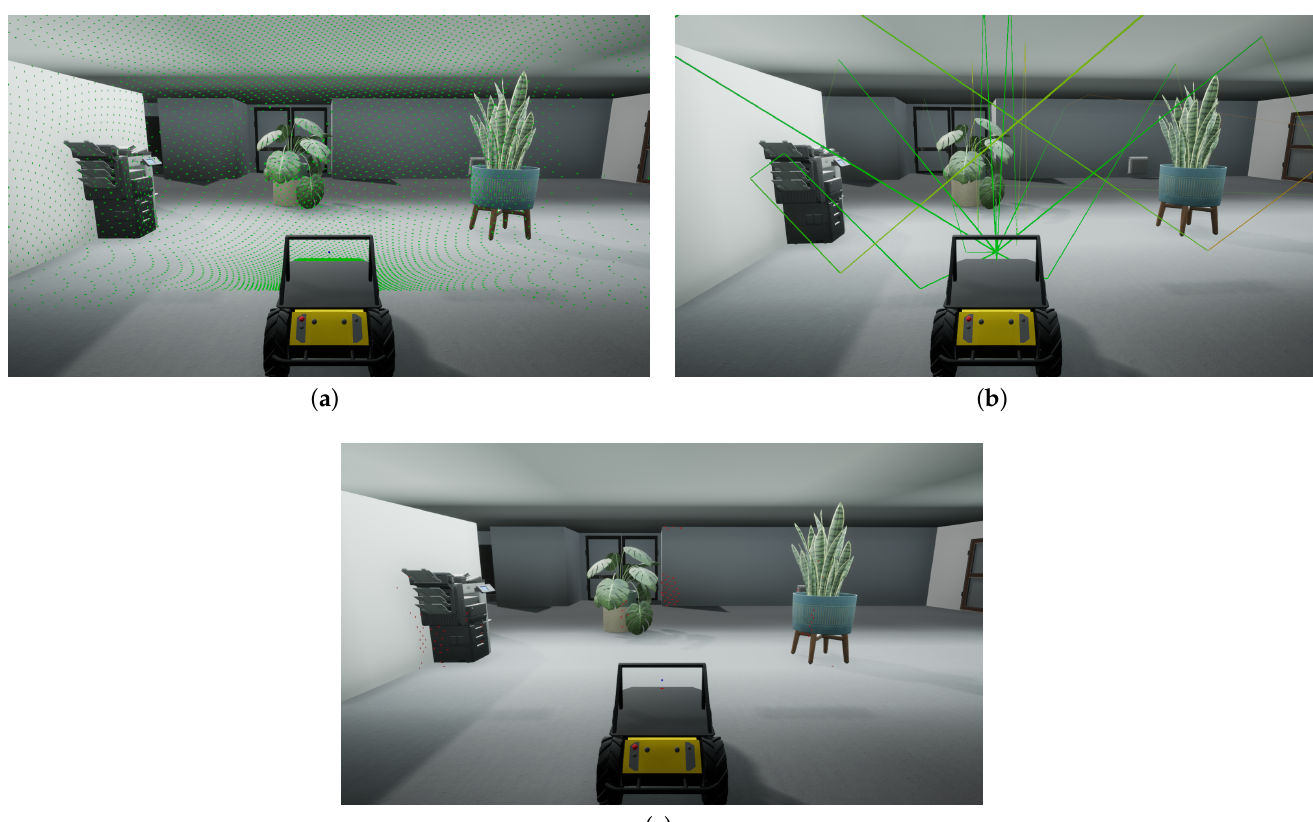
Figure 2. Overview of the simulation steps in the Unreal engine. ( a ) The impact locations of the initial rays cast into the environment (green dots). ( b ) The paths of selected rays as they propagate through the environment (colored lines). ( c ) The locations of reflected rays that have reached the sensor (red